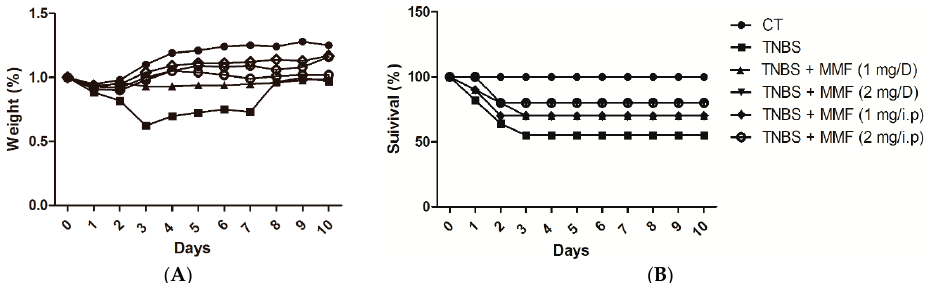
Figure 1. Effects of MMF treatment on the development, the survival rate and the body weight in mice with TNBS-induced colitis. Colitis was induced by the intracolonic administration of TNBS (2 mg per mouse) in 50% ethanol. Mice were treated with MMF, which was administered by i.p. or gavage (1 or 2 mg) on days − 1, 0, 1, 2, and 7. Control mice received 50% ethanol alone. ( A ) The